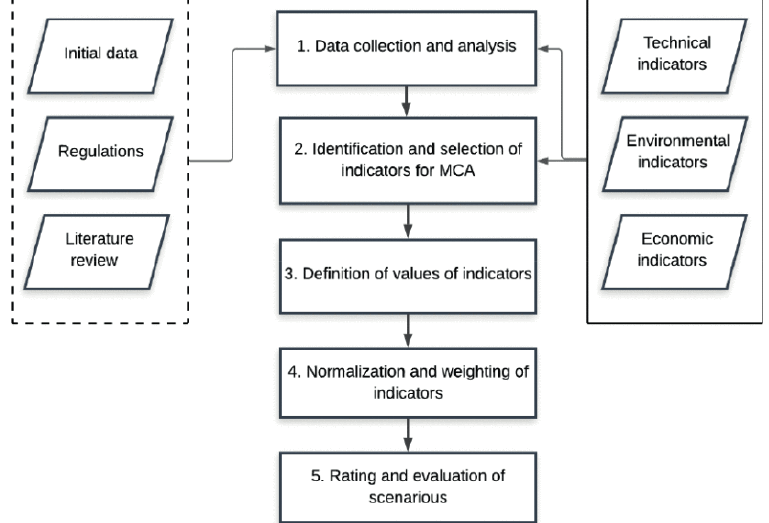
Fig. 3. Concept of the methodology